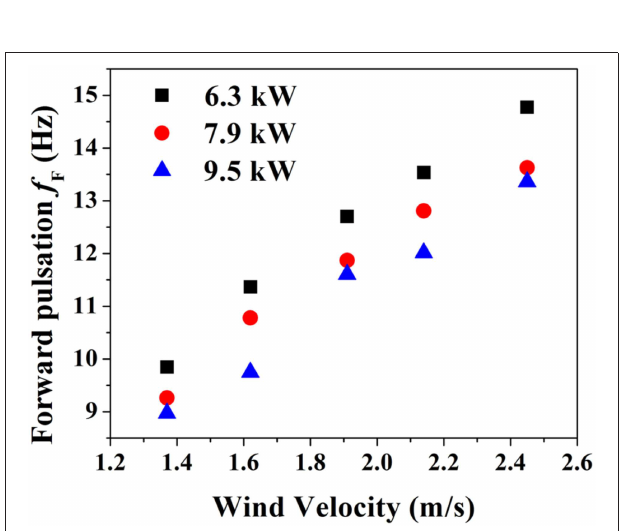
FIGURE 5 | Comparison of frequencies obtained from a FFT for different wind